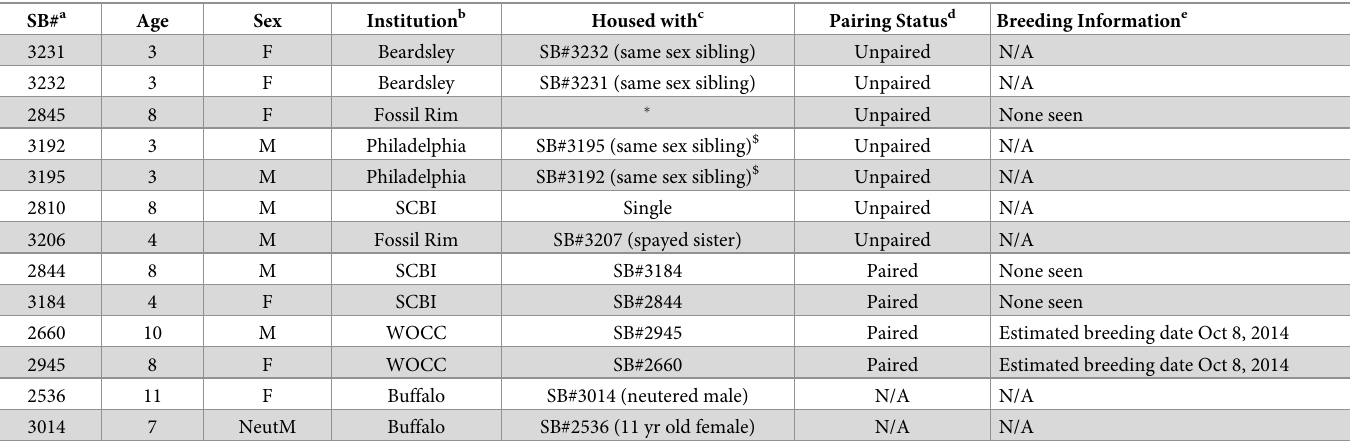
a Studbook Number. Association of Zoos and Aquarium reference number of individual pedigree and demographic history. b